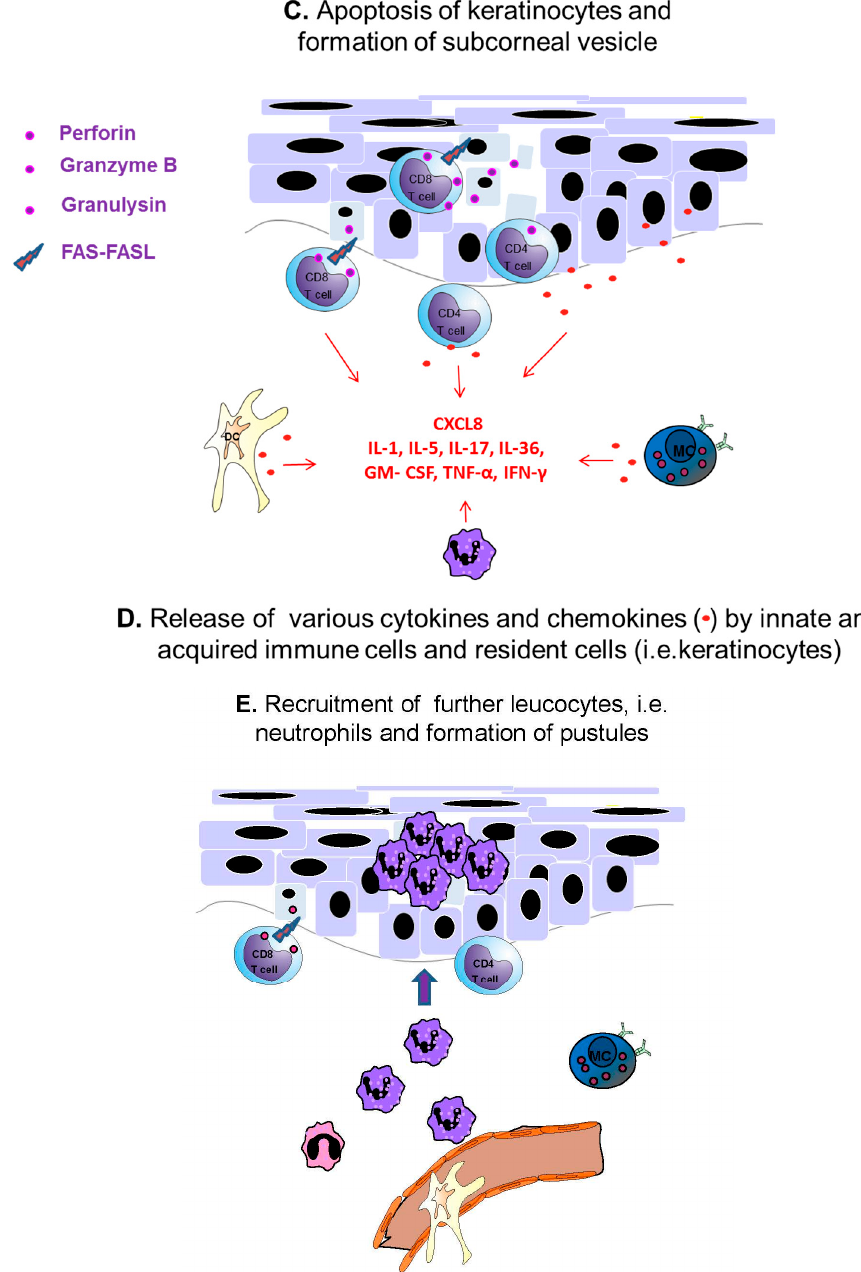
Figure 1. Putative pathogenic mechanisms in acute generalized exanthematous pustulosis (AGEP). ( A ) In cases with drug involvement, the initial phase involves stimulation of drug-specific T cells and ( B ) their migration to the skin; ( C ) These T cells, possibly together with natural killer T (NKT) cells/natural killer (NK) cells are activated in the skin, where they induce apoptosis of keratinocytes through cytotoxic proteins and Fas/Fas ligand (FasL) interactions resulting in the formation of subcorneal vesicles; ( D ) Furthermore, these T cells together with subsequently activated bystander and inflammatory cells (keratinocytes, dendritic cells (DC), MC, neutrophils) release various cytokines and chemokines; ( E ) which predominately lead to neutrophilic inflammation and the formation of pustules.